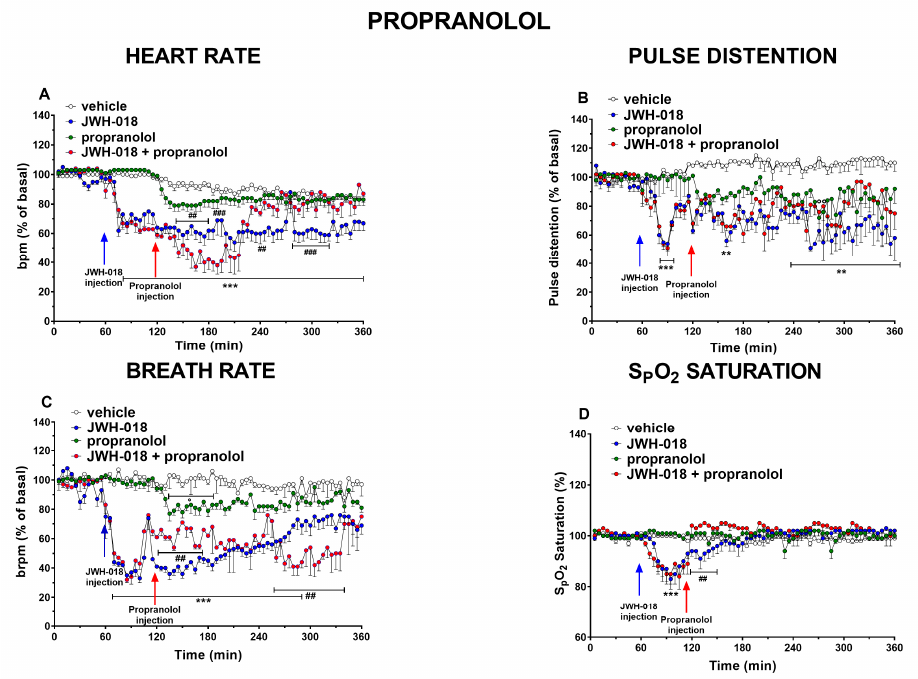
Figure 7. Effect of systemic administration of JWH-018 (6 mg/kg), propranolol (2 mg/kg), or JWH- 018 followed by propranolol on heart rate ( A ), pulse distention ( B ), breath rate ( C ), and oxygen blood saturation ( D ). Data are expressed as percentage of basal values in the form mean ± SEM of four different evaluations for each group. Statistical analysis was performed by two-way ANOVA followed by Bonferroni’s test for multiple comparisons. ** p < 0.01, *** p < 0.001, JWH-018 versus vehicle. ## p < 0.01, ### p < 0.001, JWH-018 versus JWH-018 + propranolol. ◦ p < 0.05, propranolol versus